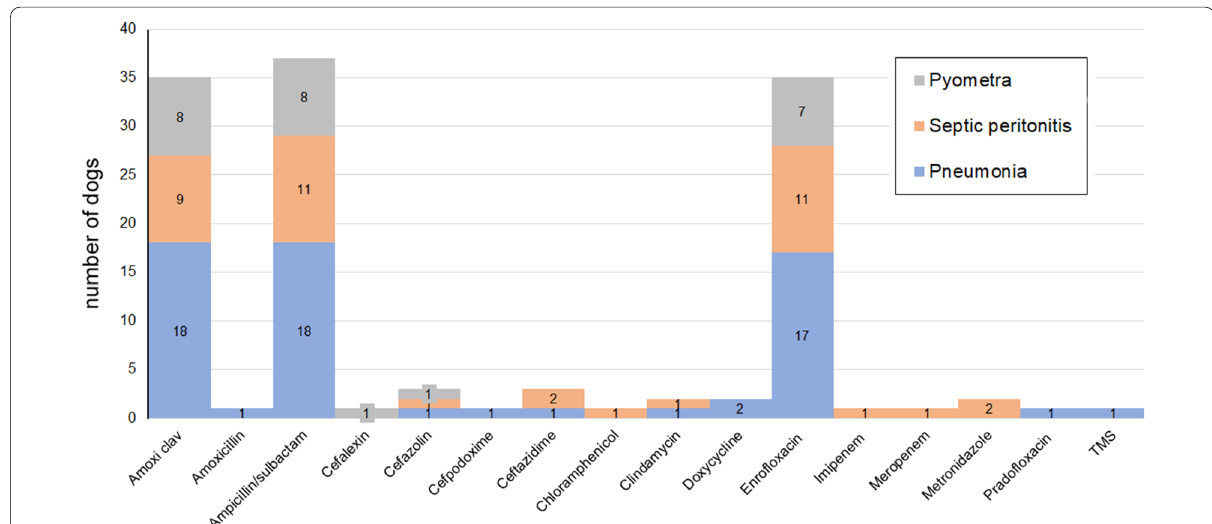
Fig. 2 Antimicrobial drugs prescribed by disease process. Amoxi/Clav Amoxicillin/clavulanate; TMS Trimethoprim‑sulfadiazine